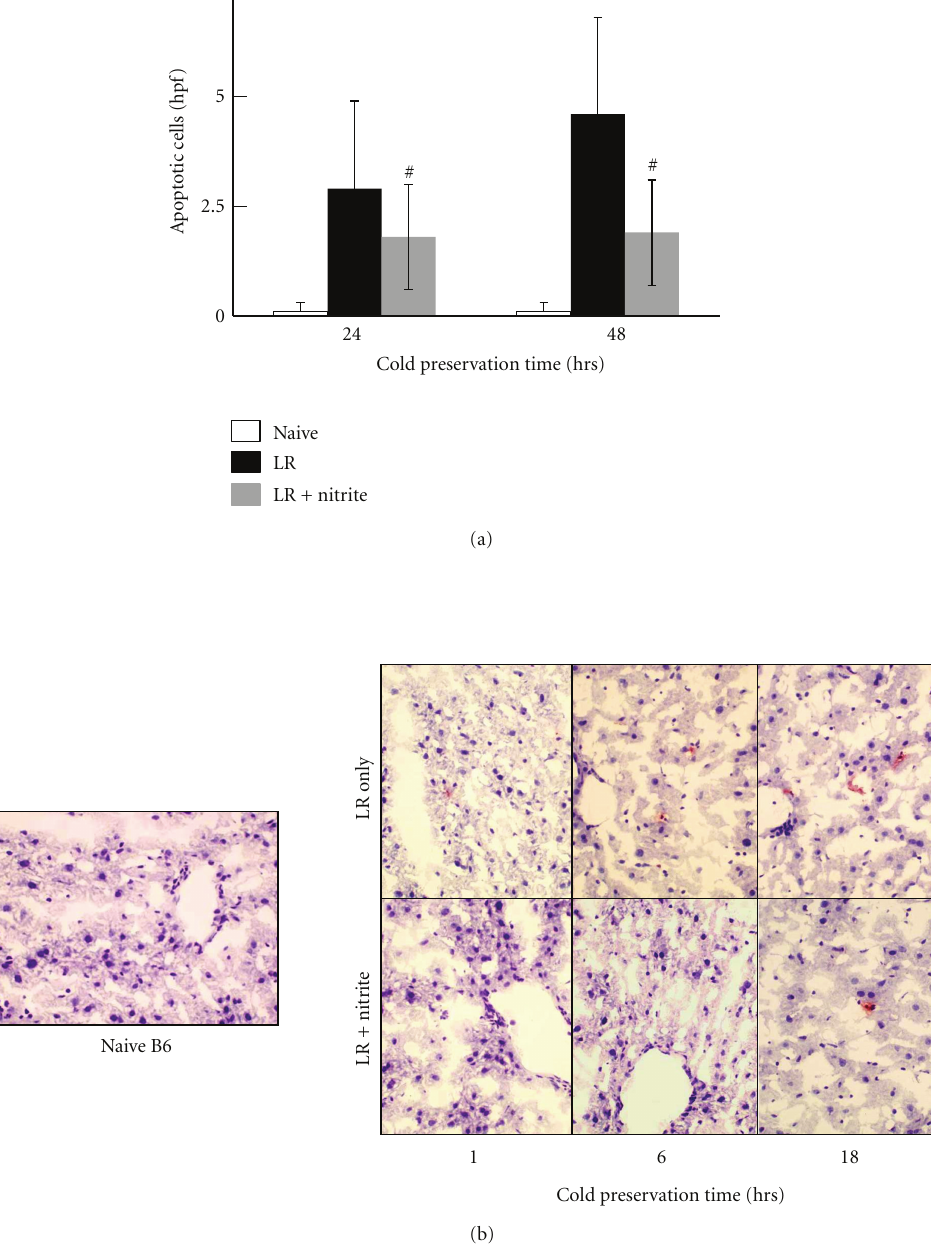
Figure 6: Nitrite reduced hepatocellular apoptosis during cold ischemia. Hepatocellular apoptosis was significantly reduced with 250 µ M of anion nitrite after 24 hours (0 . 2 ± 0 . 3 versus 2 . 9 ± 2 . 2 versus 1 . 7 ± 1 . 5) and 48 hours (0 . 2 ± 0 . 3 versus 4 . 3 ± 3 versus 1 . 8 ± 1 . 4) of cold ischemia. Data are expressed as mean ± SE. # P < 0 . 05 for corresponding